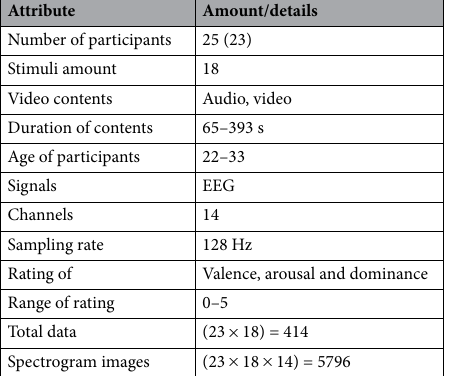
Table 2. Data dimension of EEG signals from the DREAMER